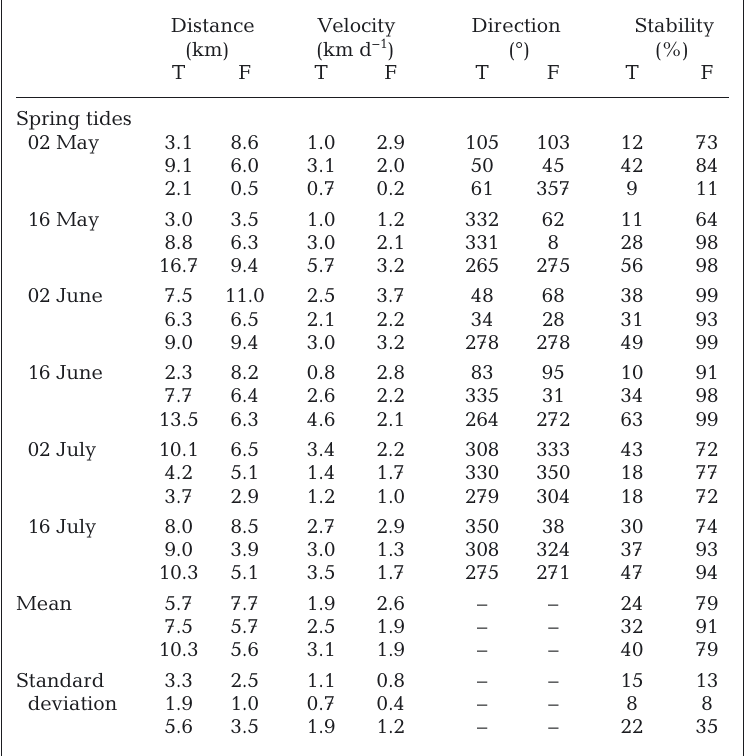
Table 3. Residual distances, velocities, directions and stability coming from progressive vector diagrams during 6 spring tide periods. T: total currents and F: filtered currents. Each of these periods spans 3 d starting on the date shown. Each cell includes surface (upper), midwater (center) and bottom